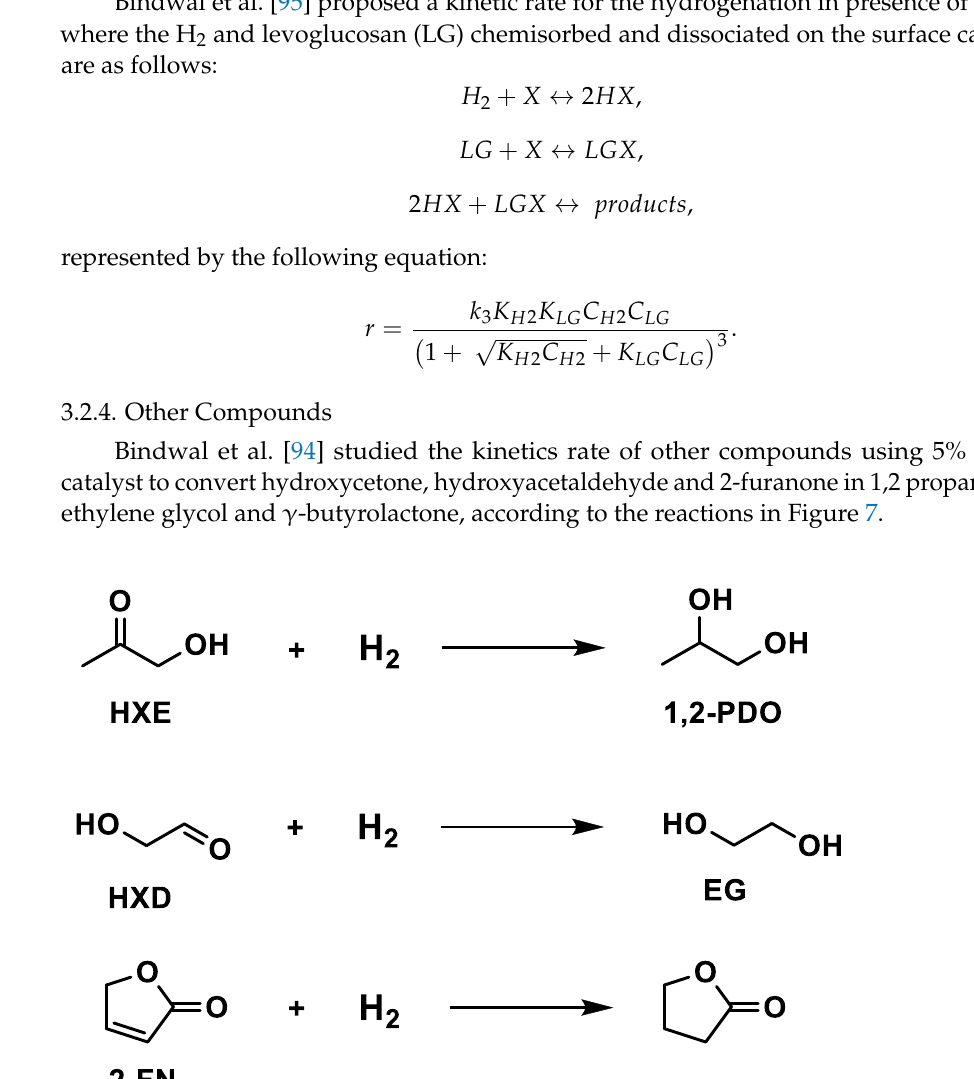
Figure 6. Levoglucosan reaction path.